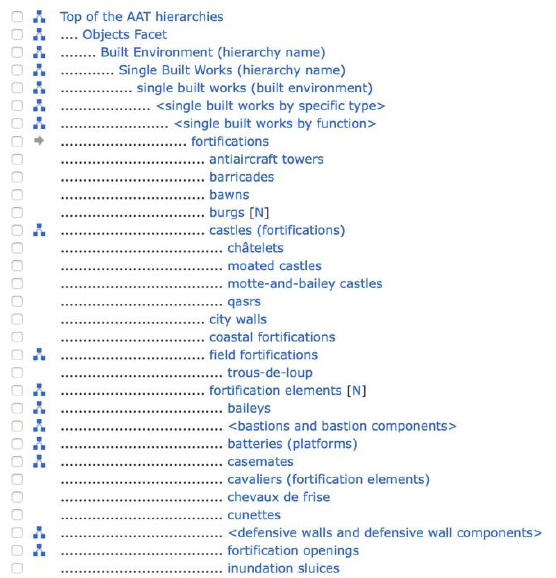
Figure 5. An extract of the Getty AAT vocabulary hierarchy related to the term